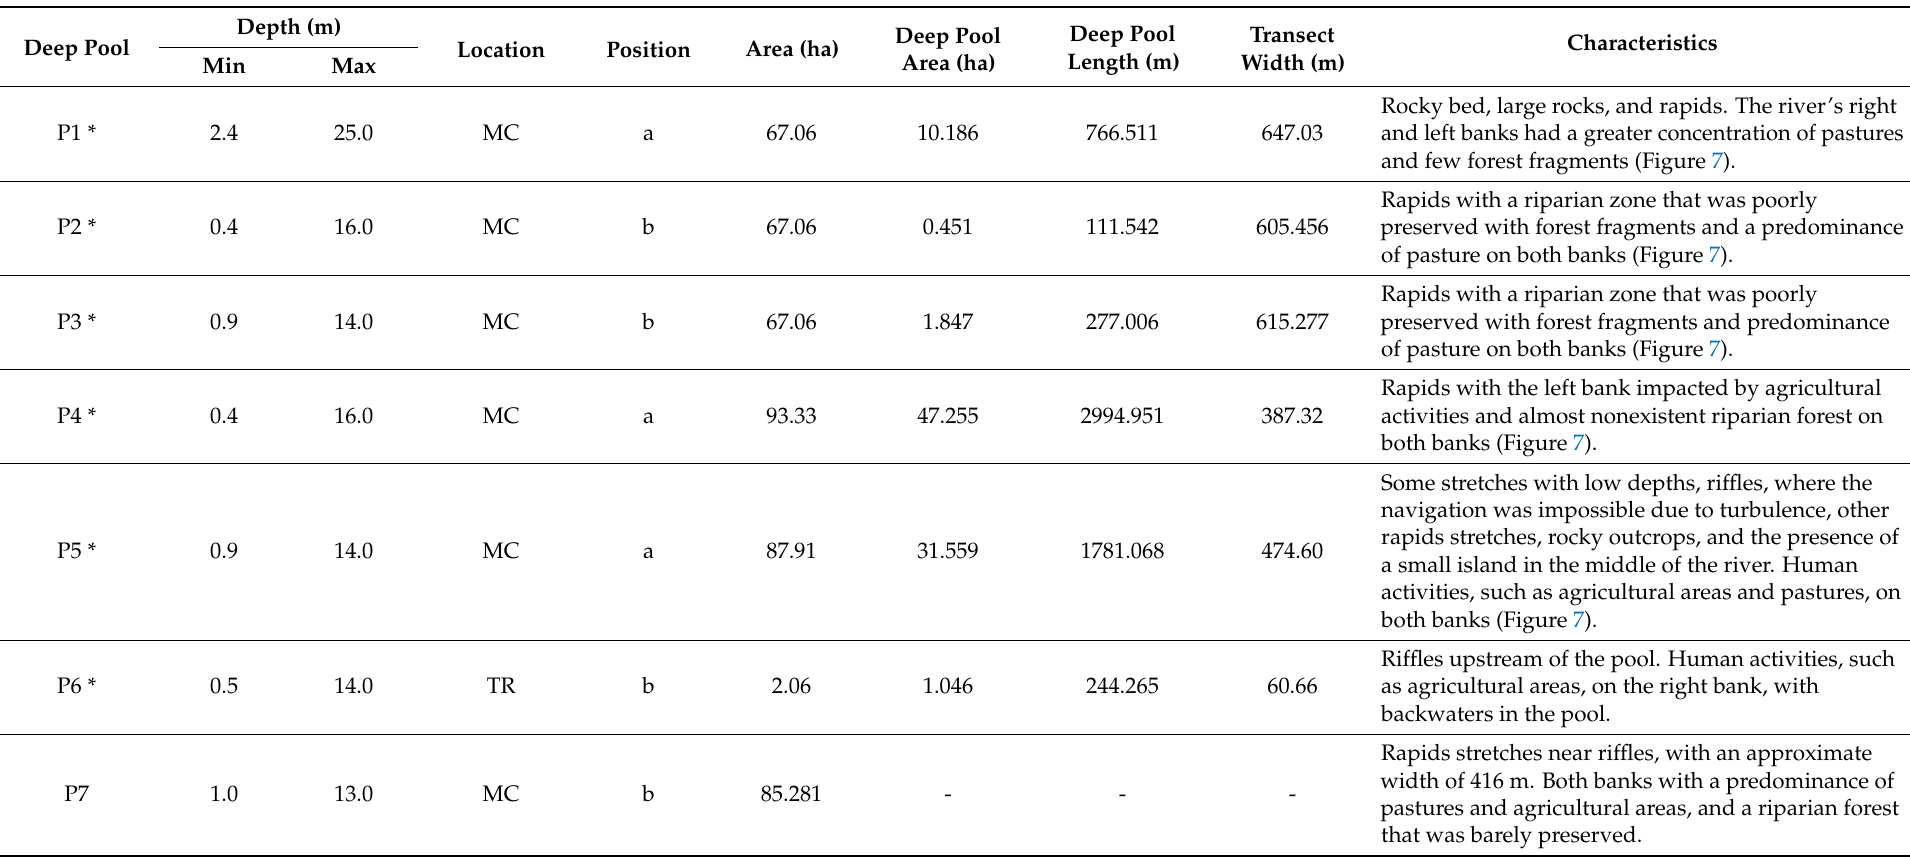
Table 2. Data of depth variations (min: minimum; max: maximum), location of deep pools (MC: main channel; TR: tributary), deep pool positions (a: pool at meander; b: pool at main channel; c: pool downstream of mid-channel island), sampling area, transect width, and main characteristics of the deep pools from downstream of the Salto Caxias Dam to upstream of the Iguaçu Falls. The general sampling areas of pools P1, P2, and P3 were the same, as these pools were very close. Asterisks (*) indicate where the bathymetry was performed to characterize the deep